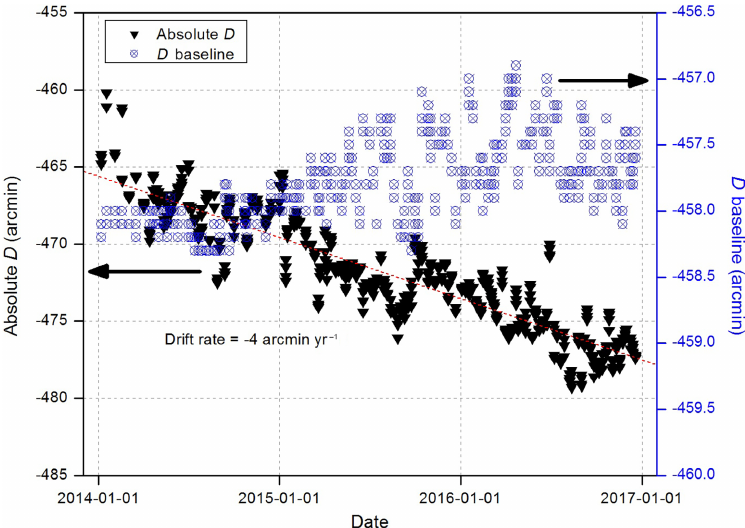
Figure 10. Comparison of D baselines (circle with cross) and absolute D (triangle) from 2014 to 2016. The dashed line is the linear fit to the absolute